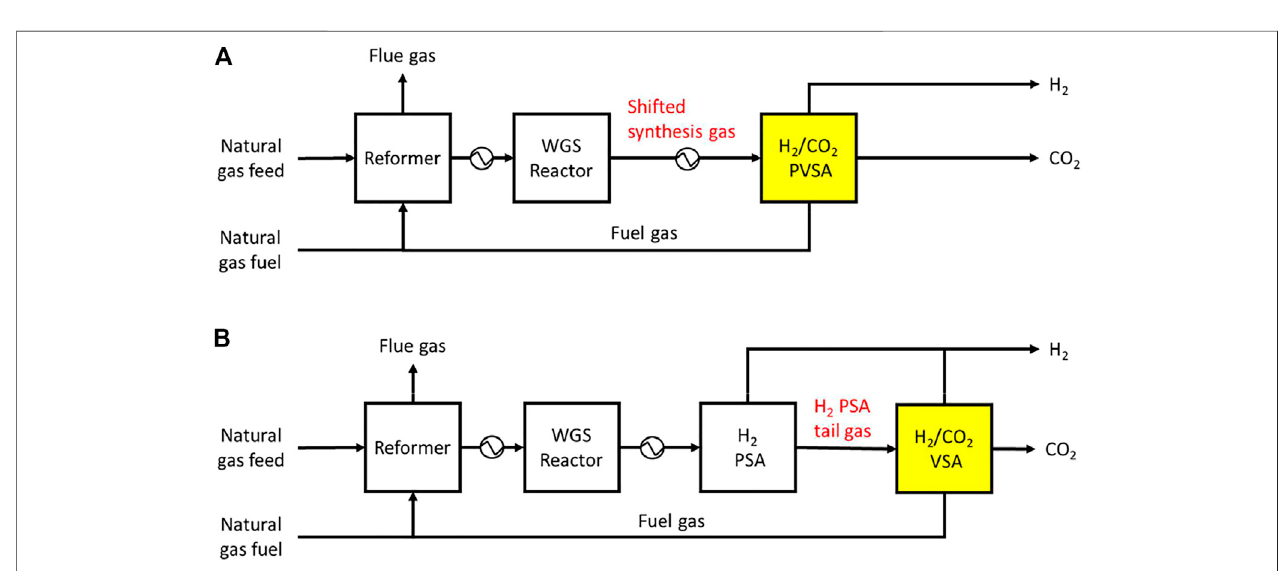
FIGURE 2 | Block fl ow diagram of an SMR hydrogen plant integrated with a 5-step VPSA for CO 2 capture: (A) syngas capture and (B) tail gas capture.